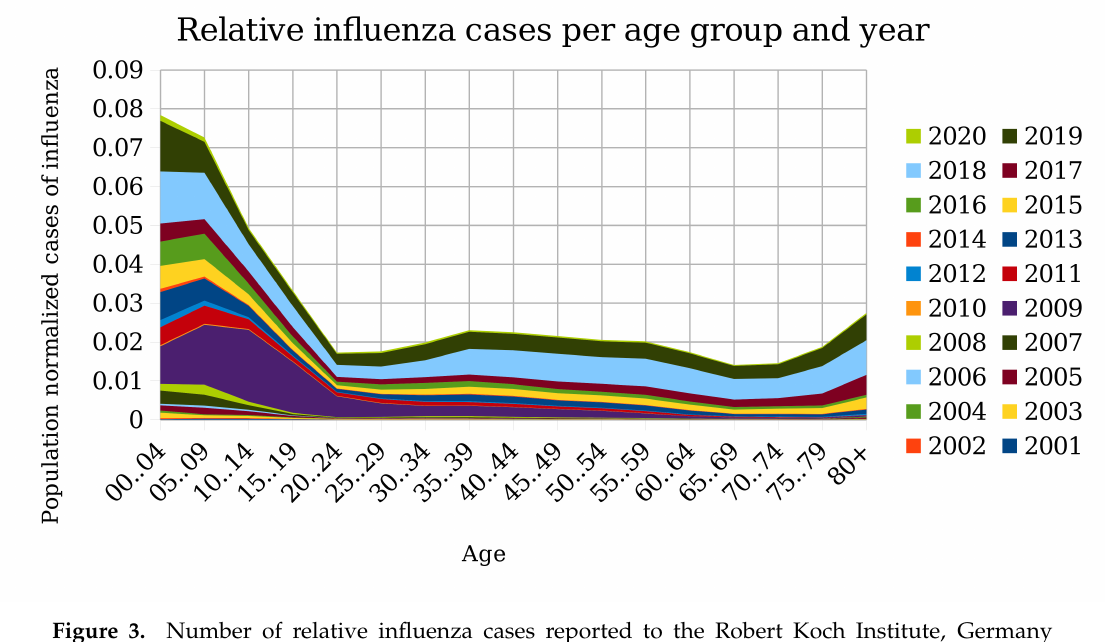
Figure 3. Number of relative influenza cases reported to the Robert Koch Institute, Germany (SurvStat@RKI 2.0, https://survstat.rki.de, Query date: 2020.02.17) divided by population size (United Nations, Department of Economic and Social Affairs, Population Division (2019). World